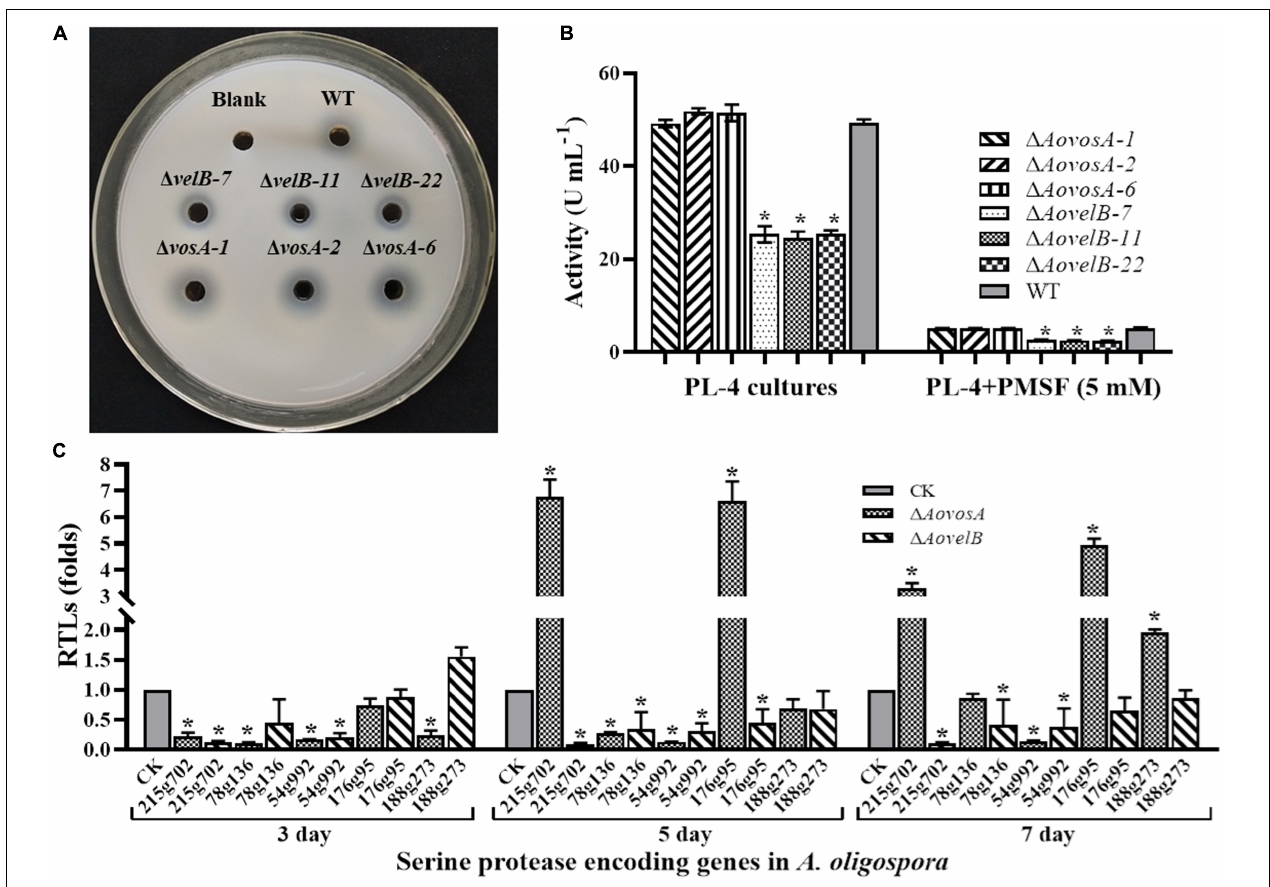
FIGURE 7 | Comparison of extracellular proteolytic activity. (A) Comparison of the extracellular proteolytic activities of the WT and mutant lines on casein plates. (B) Total extracellular protease activity quantified from 7 days old PL-4 cultures. (C) Relative transcriptional levels (RTLs) of serine protease genes in the (cid:49) AovelB and (cid:49) AovosA mutants compared with the WT strain at different time points. CK. The level of each gene was computed as a ratio of the transcript level of the gene in the deletion mutant to that in the WT strain under a given condition. An asterisk indicates a significant difference between the mutants and the WT strain ( p <